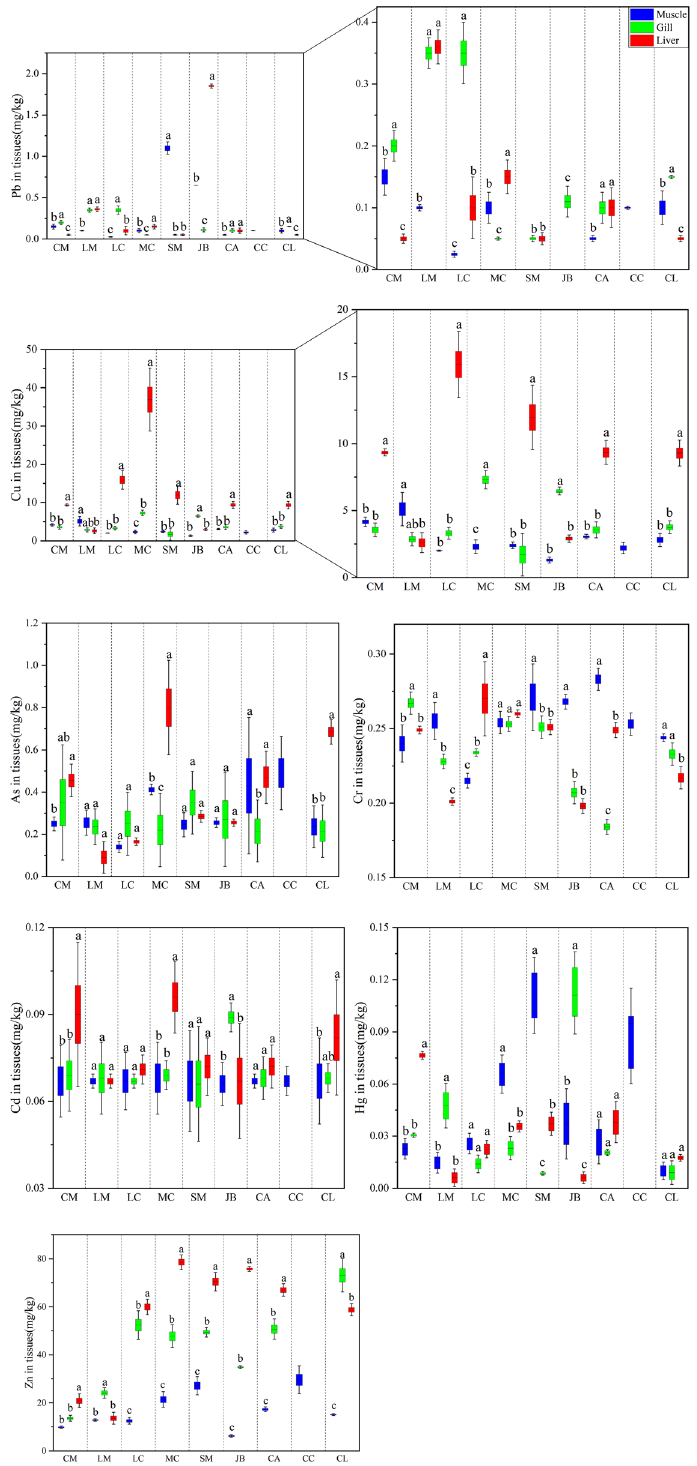
Figure 4. Concentrations of heavy metals (ww) in the muscles (blue), gills (green), and liver (red) of nine fish species collected from Dachen fishing ground, East China Sea. Different letters are significantly different within the same fish (P <